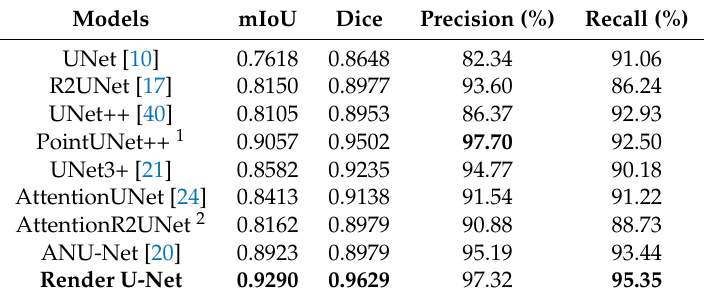
Table 3. Performance of spleen segmentation for MRI images.